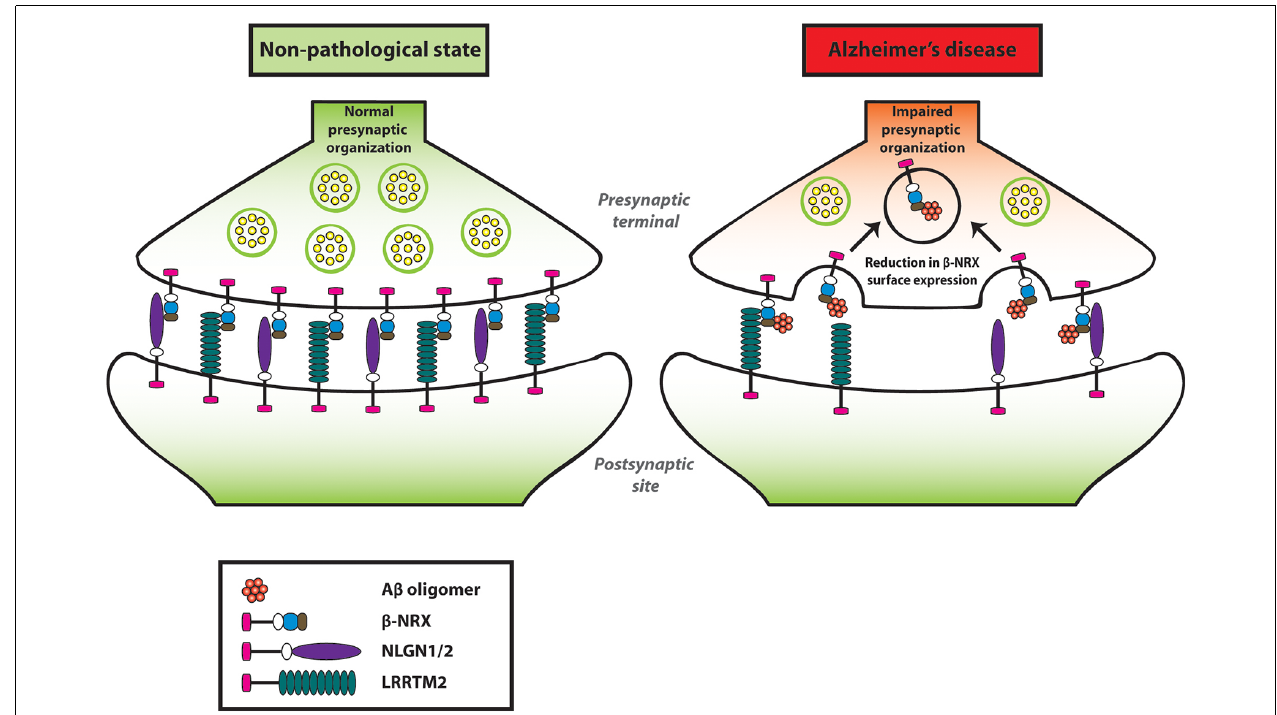
FIGURE 2 | Amyloid- β oligomers (A β Os) impair presynaptic organization by reducing β -NRXs on the axon surface. A β Os bind to the histidine-rich domain (HRD) of β -NRXs. This interaction leads to the reduction of β -NRX surface expression on the axons without interfering with its ability to bind to NLGN1 or LRRTM2. By reducing the surface level of β -NRXs, presumably through enhanced endocytosis, A β Os impair NLGN1/2- and LRRTM2-mediated presynaptic